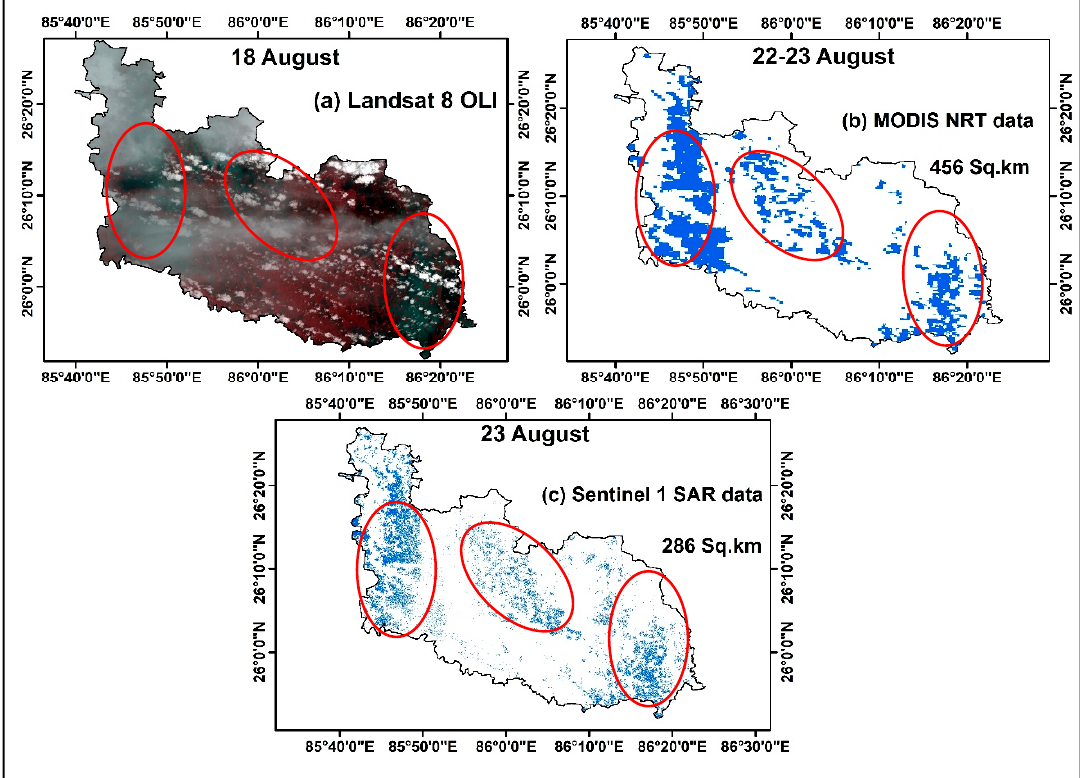
Figure 7. Flood extent map of MODIS NRT ( b ) and Sentinel-1A SAR ( c ) data over the Darbhanga district was shown during 22–23th August and 23rd August, respectively. The Landsat-8 (OLI) FCC image ( a ) of 18th August, 2017 was also used to verify flooding extent. The red circle indicates some of the continuous patch of flood.